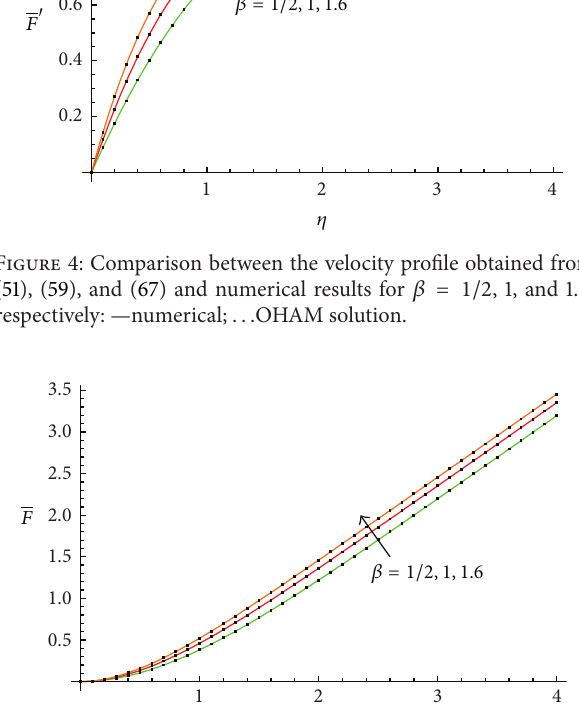
1 2 Figure7:Comparisonbetweentheapproximatesolutions(55),(63), and (71) and numerical results with the auxiliary function equation (42) in the cases 𝛽 = 1/2 , 1, and 1.6, respectively: —numerical; ... OHAM solution.